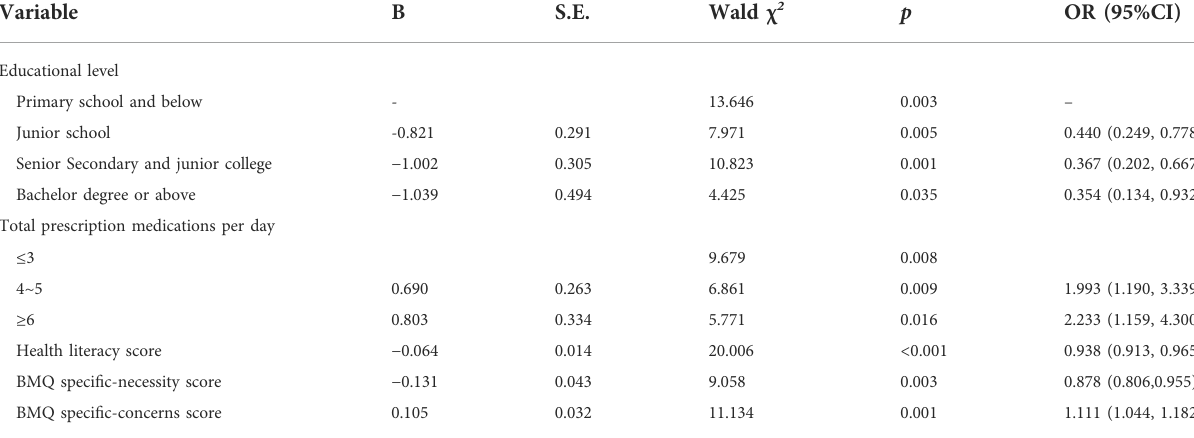
TABLE 4 Factors associated with medication non-adherence using logistic